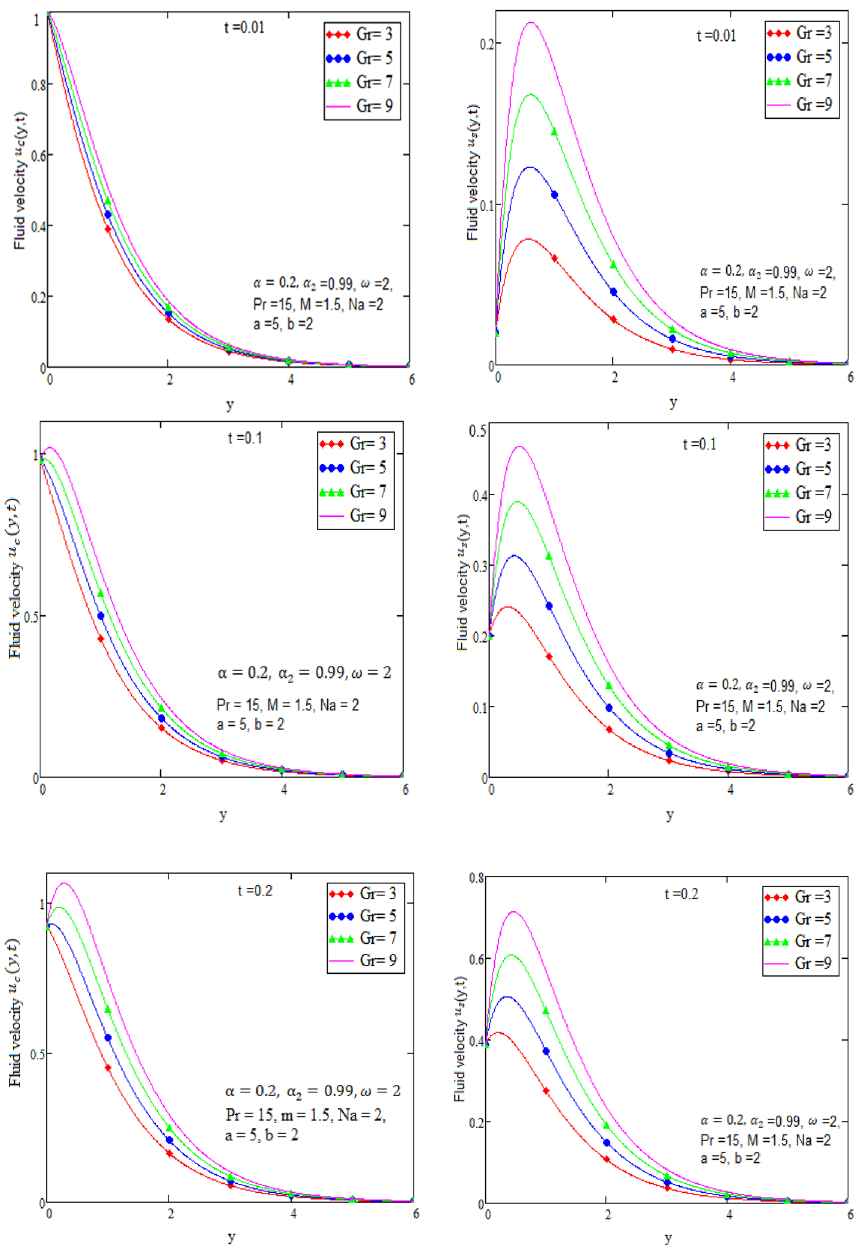
Figure 8. Graph of velocity for different value of Grashof number Gr in case of cosine and sine